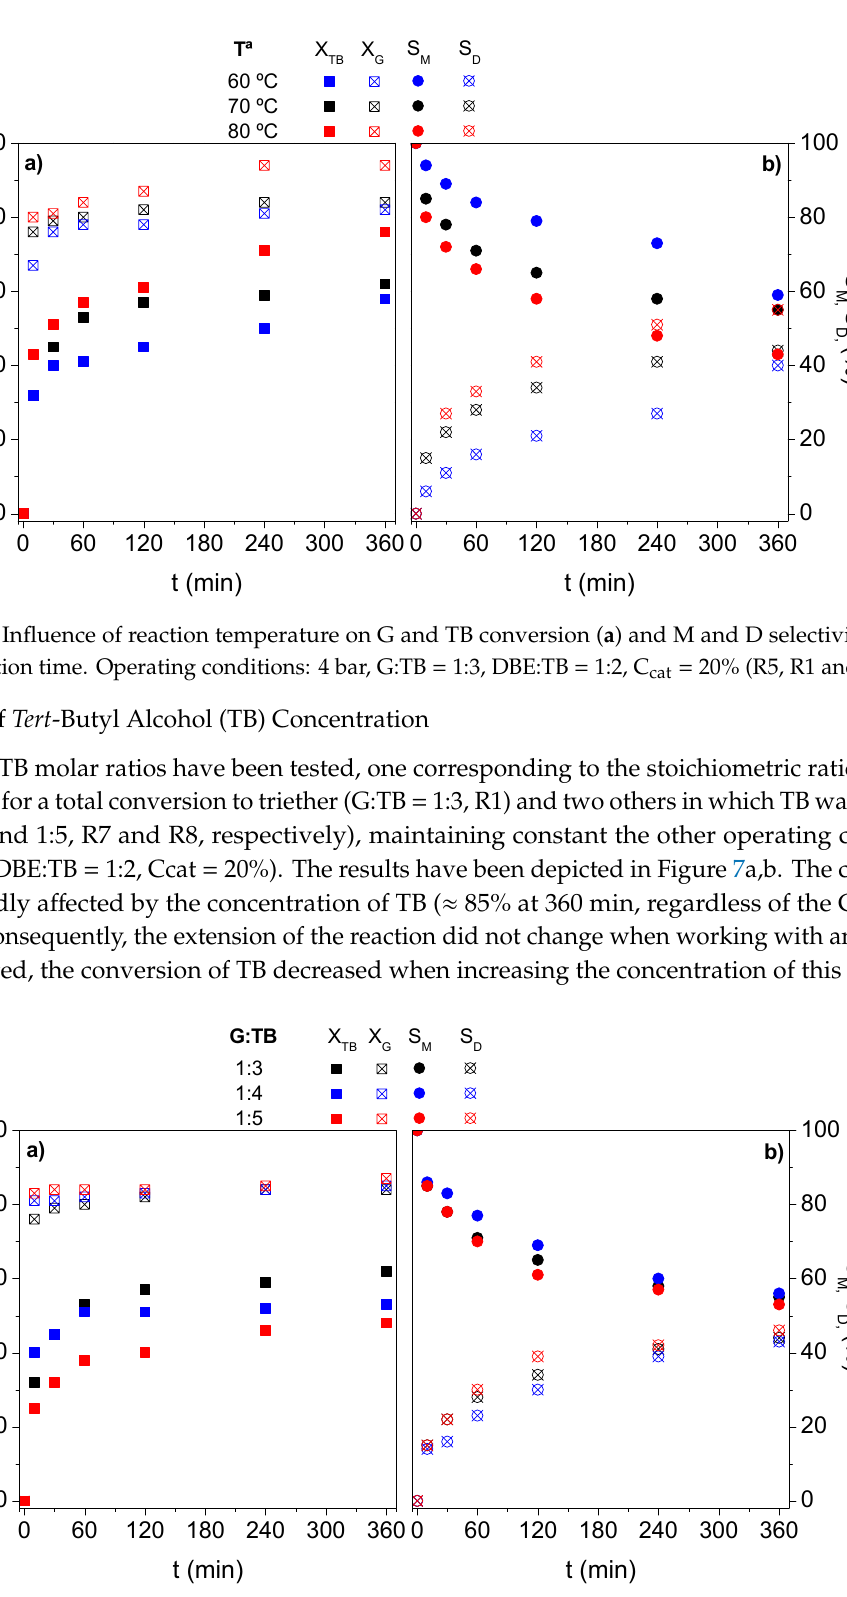
Figure 7. Influence of reaction temperature on G and TB conversion ( a ) and M and D selectivity ( b )